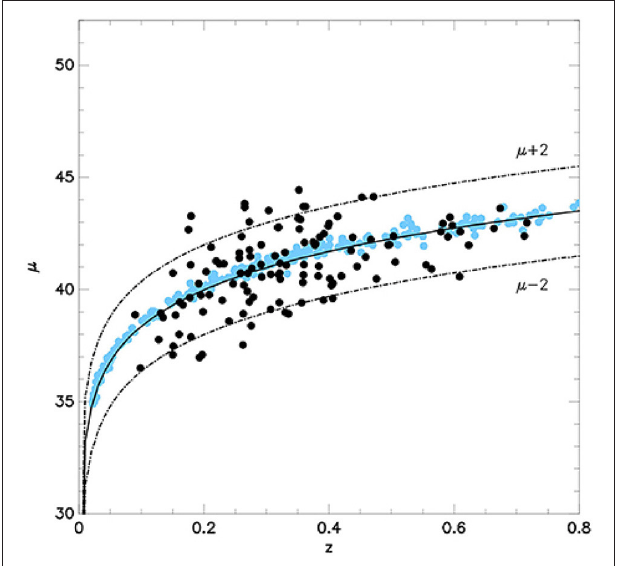
FIGURE 8 | Distance modulus of the “extreme sample” of Negrete et al. (black dots) and the Kessler et al. (2009) SDSS-II SN sample (cyan dots) as a function of redshift. The solid curve is the expected distance modulus µ for concordance cosmology. The dotted-dash lines delimit the area with magnitudes with respect to the concordance model. From Negrete et al.